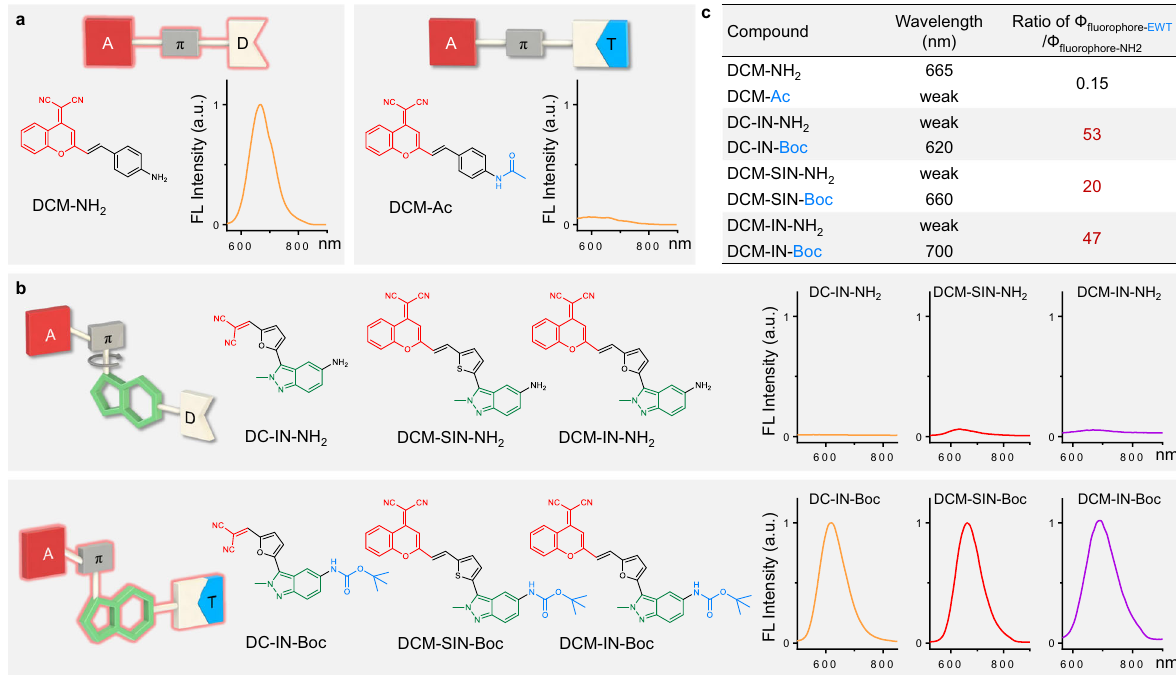
Fig. 2 Fluorescence umpolung of indazole-based fl uorophores. a Fluorescence spectra of DCM-NH 2 (10 μ M) and its electron-withdrawing acetyl- substituted product DCM-Ac (10 μ M) in DMSO. b Design of indazole-based fl uorophores: starting with D- π -A fl uorophore as the motif; inserting an indazole building block between the π -bridge and donor. Fluorescence spectra of these indazole-based fl uorophores indicated their fl uorescence umpolung properties. The D-indazole- π -A type dyes displayed weak emission intensity, whereas their electron-withdrawing Boc-substituted products (EWT- indazole- π -A type dyes) exhibited strong fl uorescence. Fluorescence spectra of each pair of the amino-substituted fl uorophore and its EWT-substituted fl uorophore were recorded in the same test condition (10 μ M, in DMSO). c Emission wavelength and EWT-induced enhancement of fl uorescence quantum yield in solution-state (the ratio of Ф fl uorophore-EWT / Ф fl uorophore-NH2